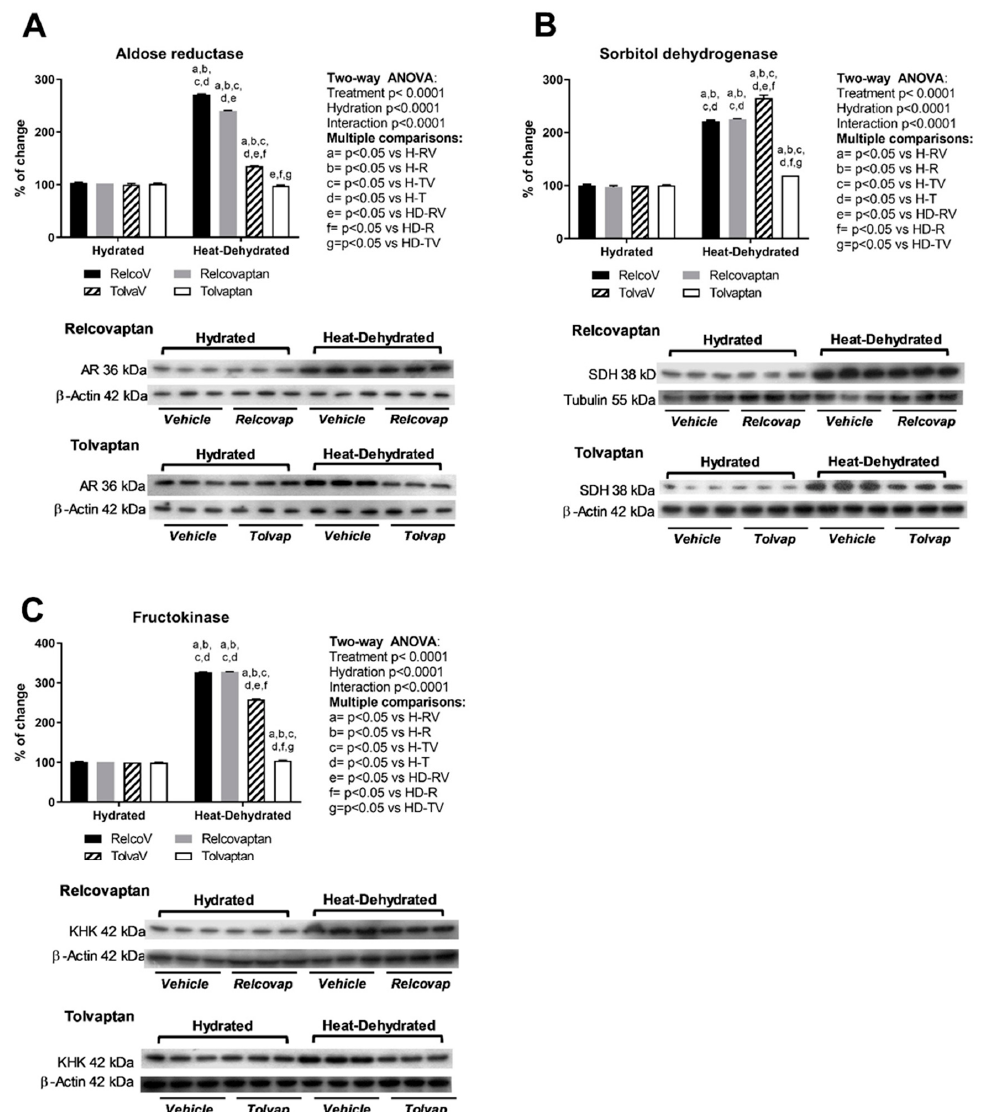
Figure 3. Effects of tolvaptan on polyol and fructokinase pathways. Tolvaptan prevented the overexpression of ( A ) aldose reductase, ( B ) sorbitol dehydrogenase, and ( C ) fructokinase in heat stress-dehydrated rats rehydrated with a 10% fructose beverage. For western blotting, three random samples per group were selected. Proteins of interest and the respective loading controls were run independently at the same time using the same conditions. The raw dataset is available in the Supplementary Materials.